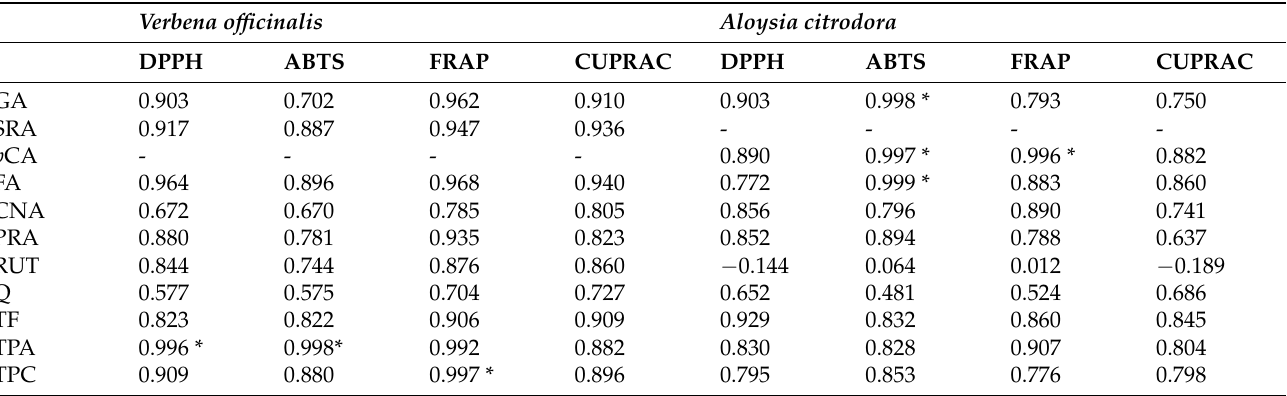
Table 6. Correlation coefficient analysis of the phenolic composition and antioxidant activity in Verbena officinalis and Aloysia citrodora